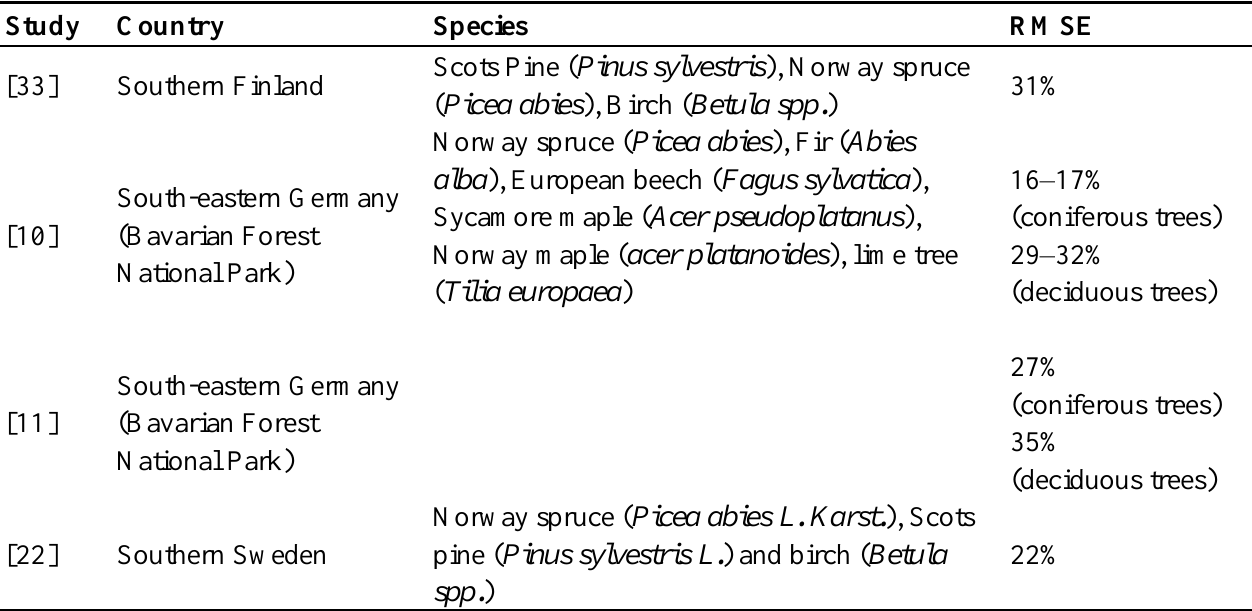
Table 11. Selection of earlier studies carried out in Germany and Scandinavia to estimate individual tree stem volume from remote sensing